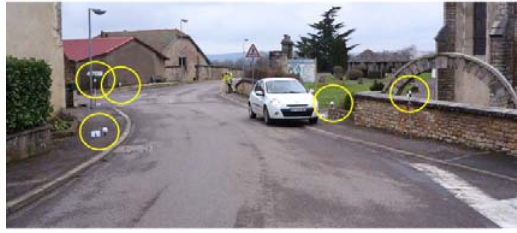
Fig. 11: Reference points for scene